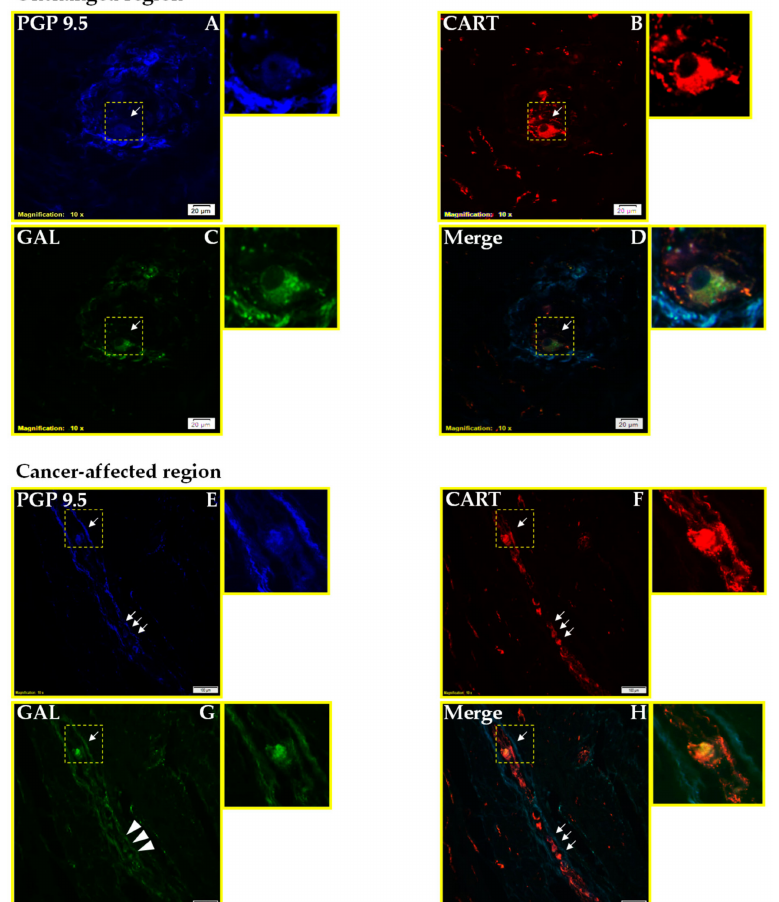
Figure 2. Micrographs showing myenteric plexi which were triple immunostained for cocaine- and amphetamine-regulated transcript (CART), galanin (GAL), and protein-gene product 9.5 (PGP 9.5; as a pan-neuronal marker). Small-sized arrows show double- or triple-stained cells, while large-sized arrows pointed out the lack of occurrence of studied substances. Micrographs D and H showing the superposition of all three channels: blue—PGP 9.5, red—CART, and green—GAL. In the macroscopically unchanged human stomach wall, one PGP 9.5-immunoreactive (-IR, ( A )) neuron which was simultaneously CART-IR ( B ) and GAL-IR ( C ). In the cancer-affected human stomach wall, a moderate number of PGP 9.5-IR ( E ) neurons which were simultaneously CART-IR ( F ) but negative for GAL ( G ), and only one PGP 9.5-IR neuron which was simultaneously CART-IR ( F ) and GAL-IR ( G ). Colocalization of all antigens in the studied neuron ( D , H ). Scale bar = 20 µ m and 100 µ